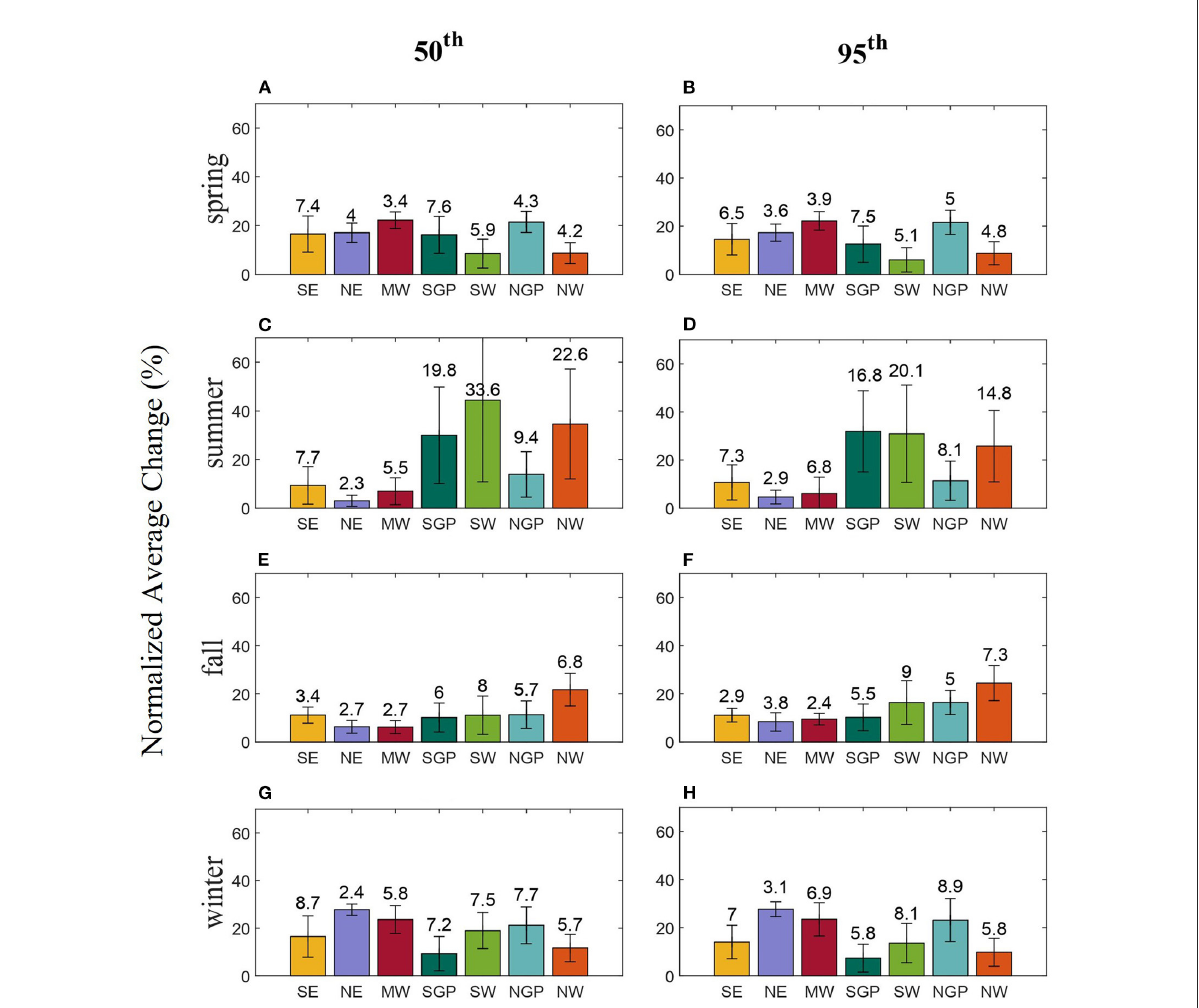
FIGURE7 Normalized regional average change of maximum SDII (mm/day) represented across seasons for the 50 th and 95 th quantiles compared to historical climatology from 1951 to 2014. Different color bar plots represent the regions of the National Climate Assessment (as shown in Figure 1), and the error bar represents the standard deviation of the normalized change within a region [spring (A) , summer (C) , fall (E) , winter (G) , spring (B) , summer (D) , fall (F) , and winter (H)